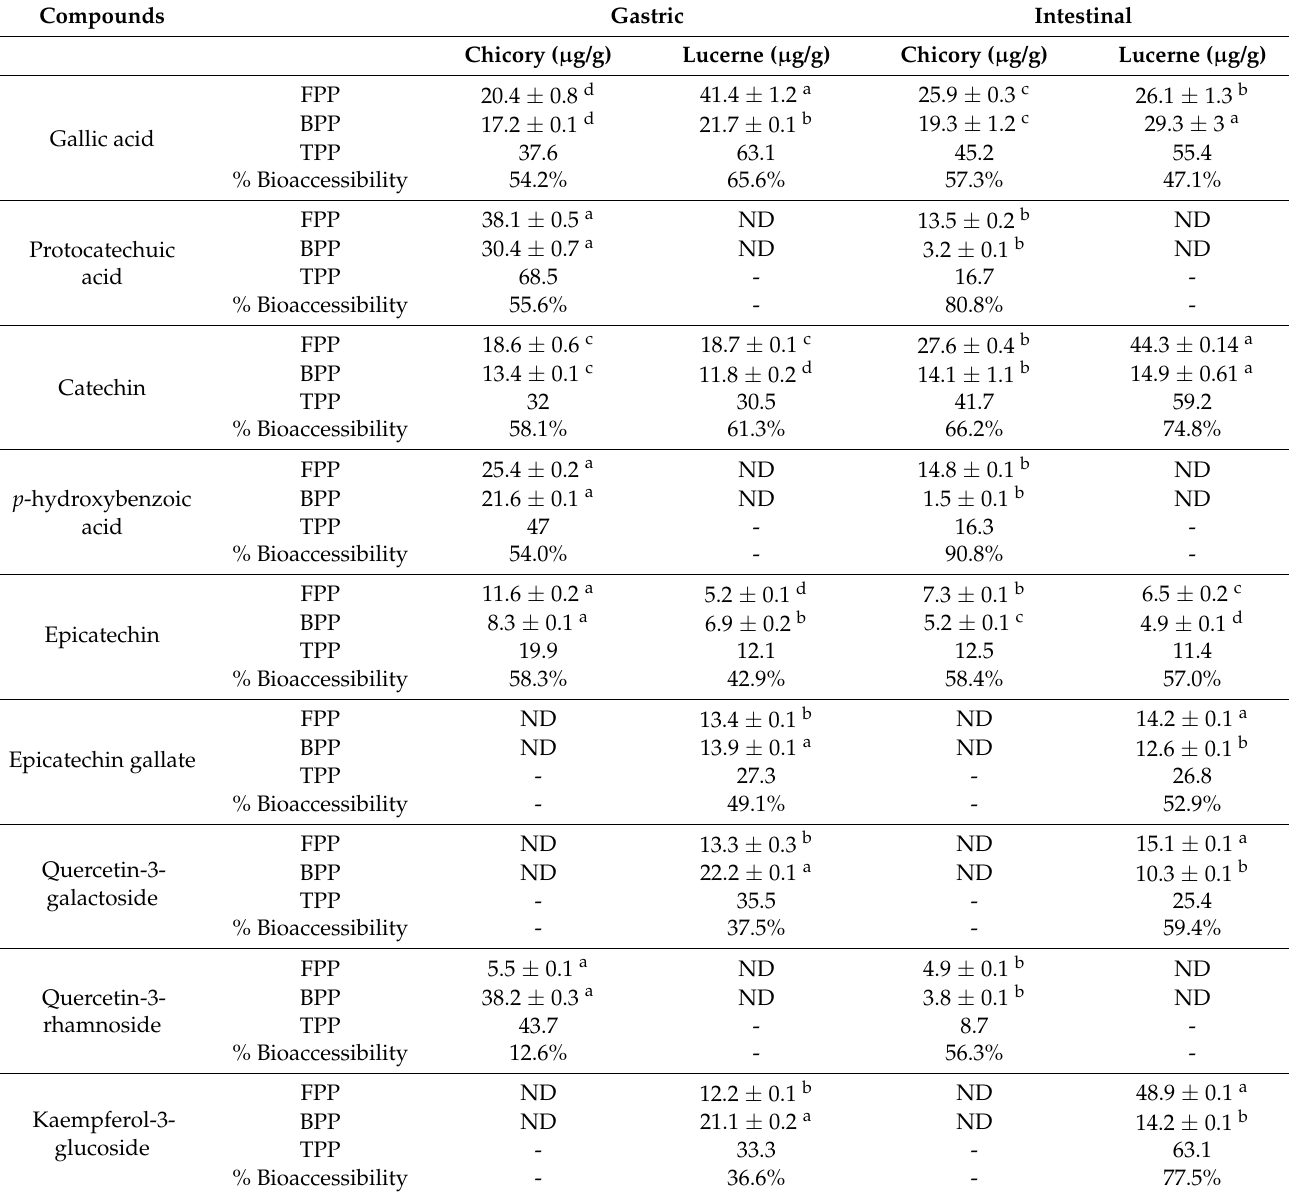
Table 2. Polyphenols released during the gastrointestinal digestion and their